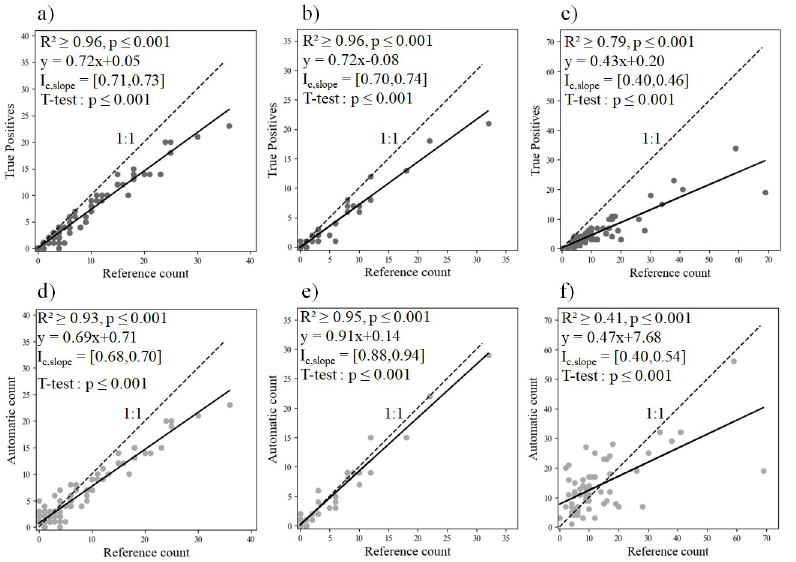
Fig 5. The method’s (a, b, c) true positives and (d, e, f) automatic count of eels as a function of the reference count for (a, d) Mauzac site/ARIS camera (MZC-ARIS), (b, e) Mauzac site/BlueView camera and (c, f) Port-La-Nouvelle site/ARIS camera. Each plot represents the number of eels counted in one hour (MZC-ARIS: n = 199; MZC-BV: n = 55; PLN-ARIS: n = 60). I c,slope is the 95% confidence interval of the slope.